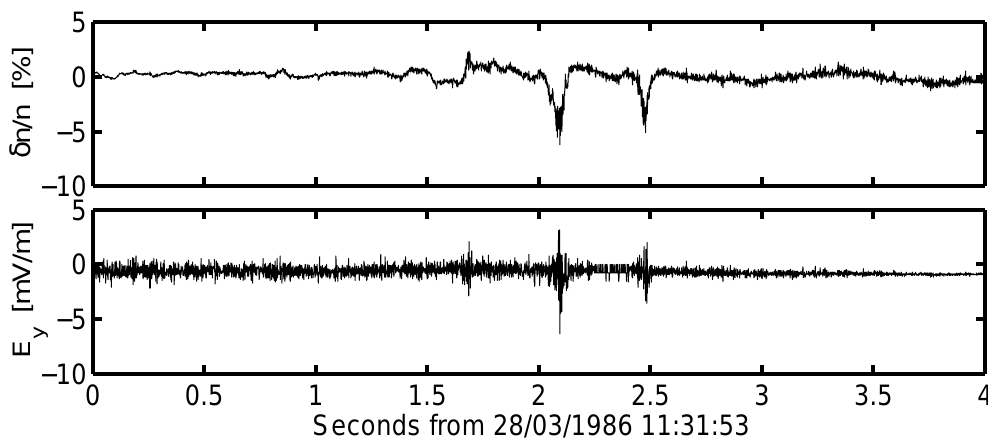
Fig. 1. Typical example of lower hybrid cavities in Viking data. The upper panel shows the density variation and the lower panel the electric field. The electric field amplitude is probably underestimated due to